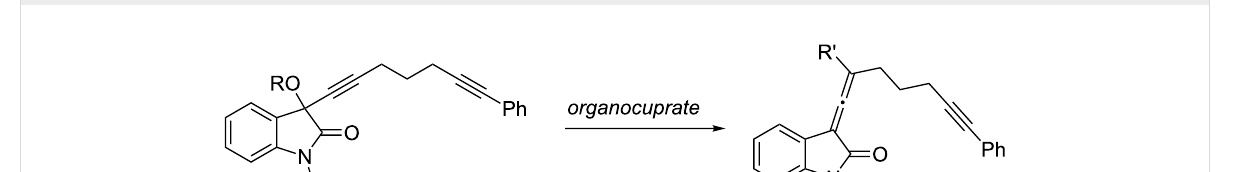
Table 1: Screening conditions for the formation of allenyloxindole 8 .